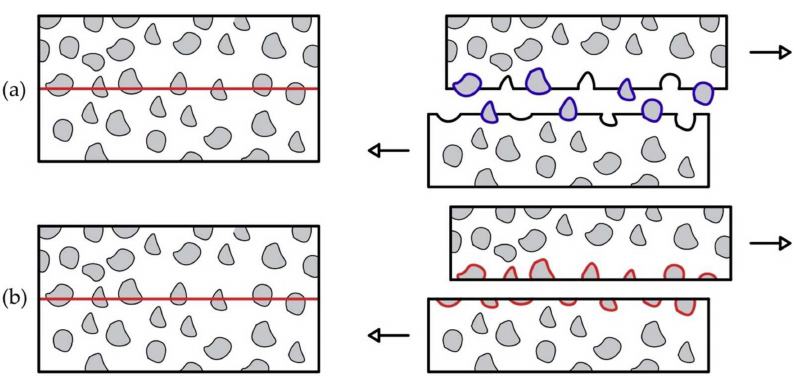
Figure 2. Crack propagation in concrete with aggregates ( a ) more and ( b ) less resistant than the cementitious